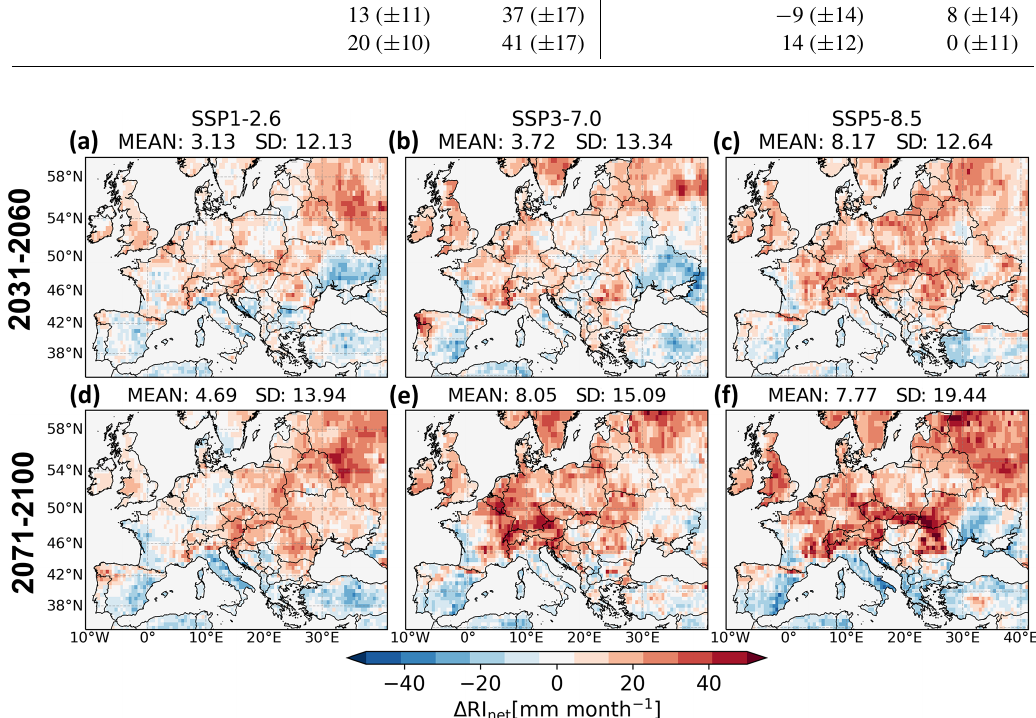
Figure 7. Future changes in RI net ( (cid:49) RI net ) (mm per month) median of five GCMs for the two future horizons (rows) and the three scenarios (columns) with reference to the baseline